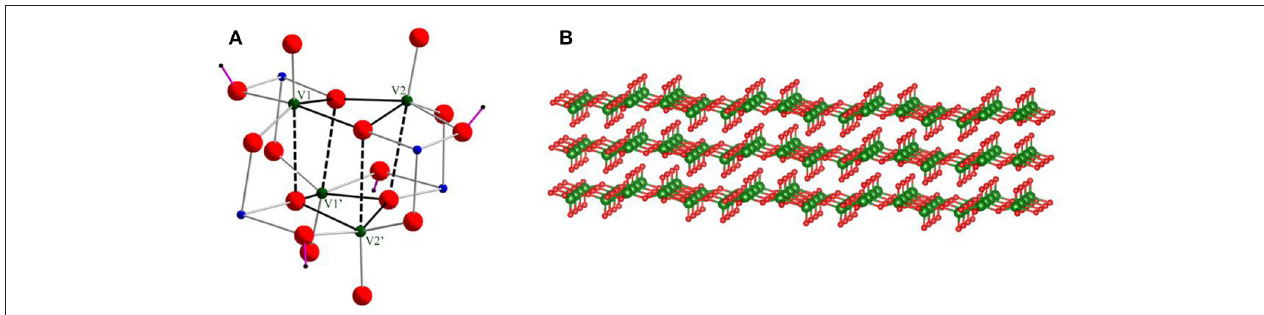
FIGURE 1 | (A) Skeletal structure of cationic cluster 1 . Green, blue, and red balls show vanadium, cobalt, and oxygen atoms, respectively. Purple lines are OH bonds. The tacn ligands on Co(III) centers are omitted for clarity. (B) V 2 O 5 layered